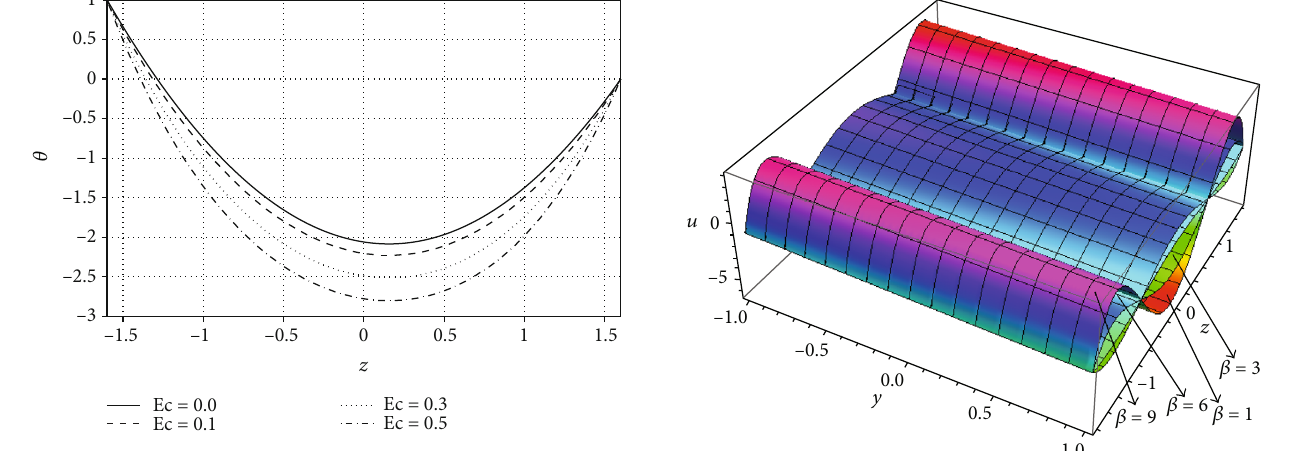
Figure 16: Temperature pro fi le for di ff erent values of Ec for fi xed values of φ = 0 : 6 , x = 0 , We = 0 : 03 , n = 2 , Q = − 1 , y = 1 , β = 0 : 2 , and Pr = 0 : 5